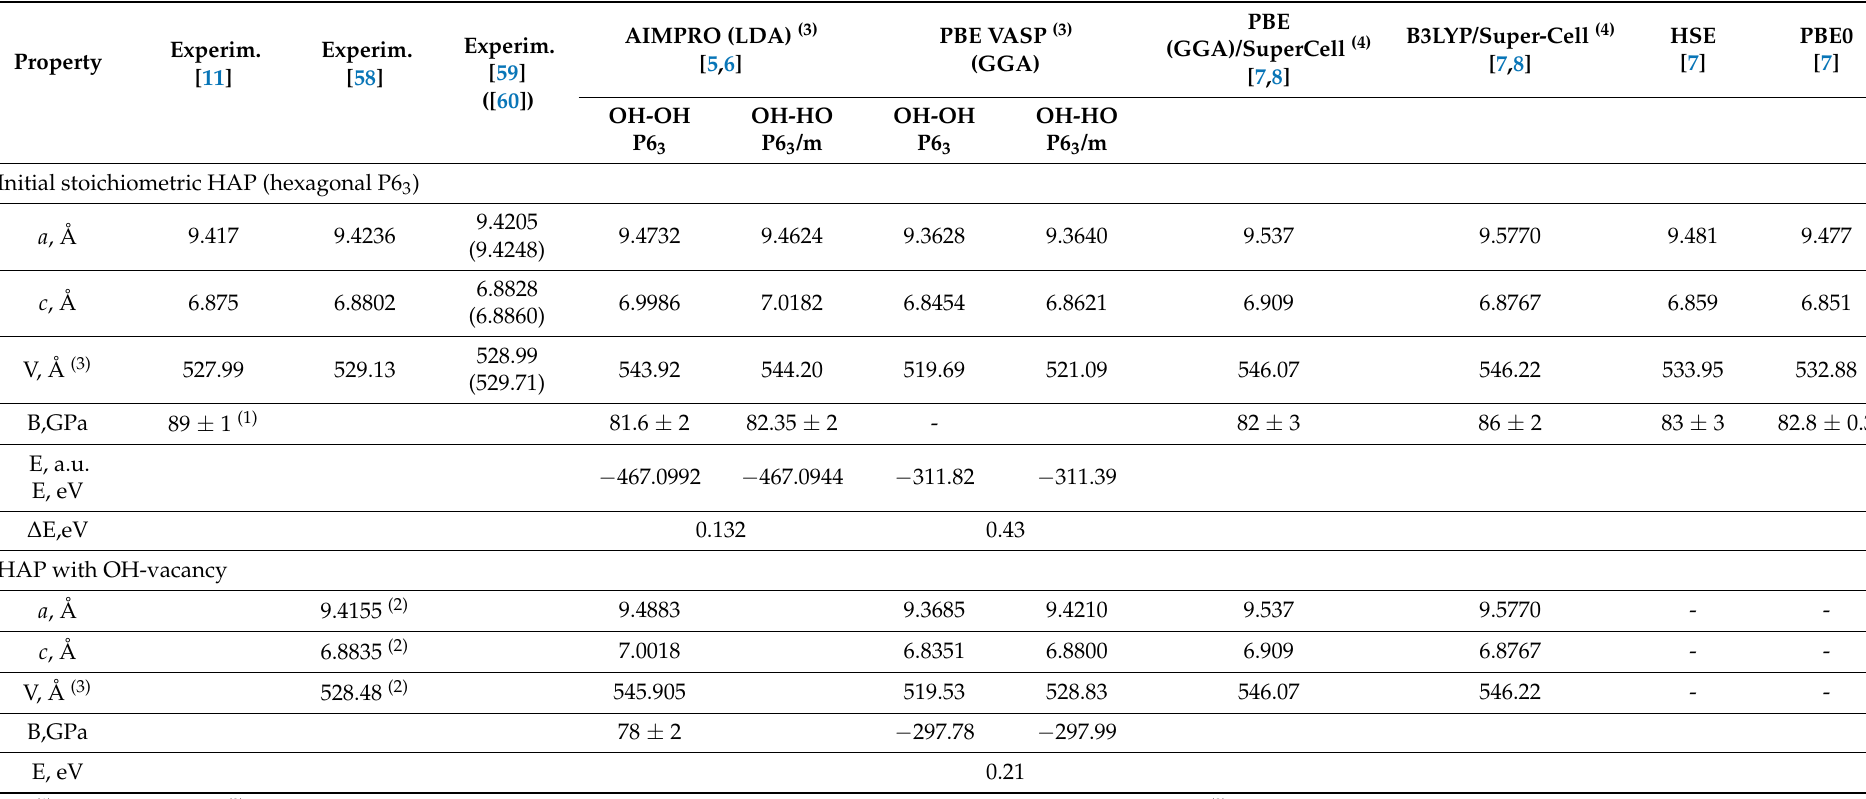
Table 2. Data of HAP lattice parameters and bulk modulus for pristine HAP and HAP with OH-vacancy.